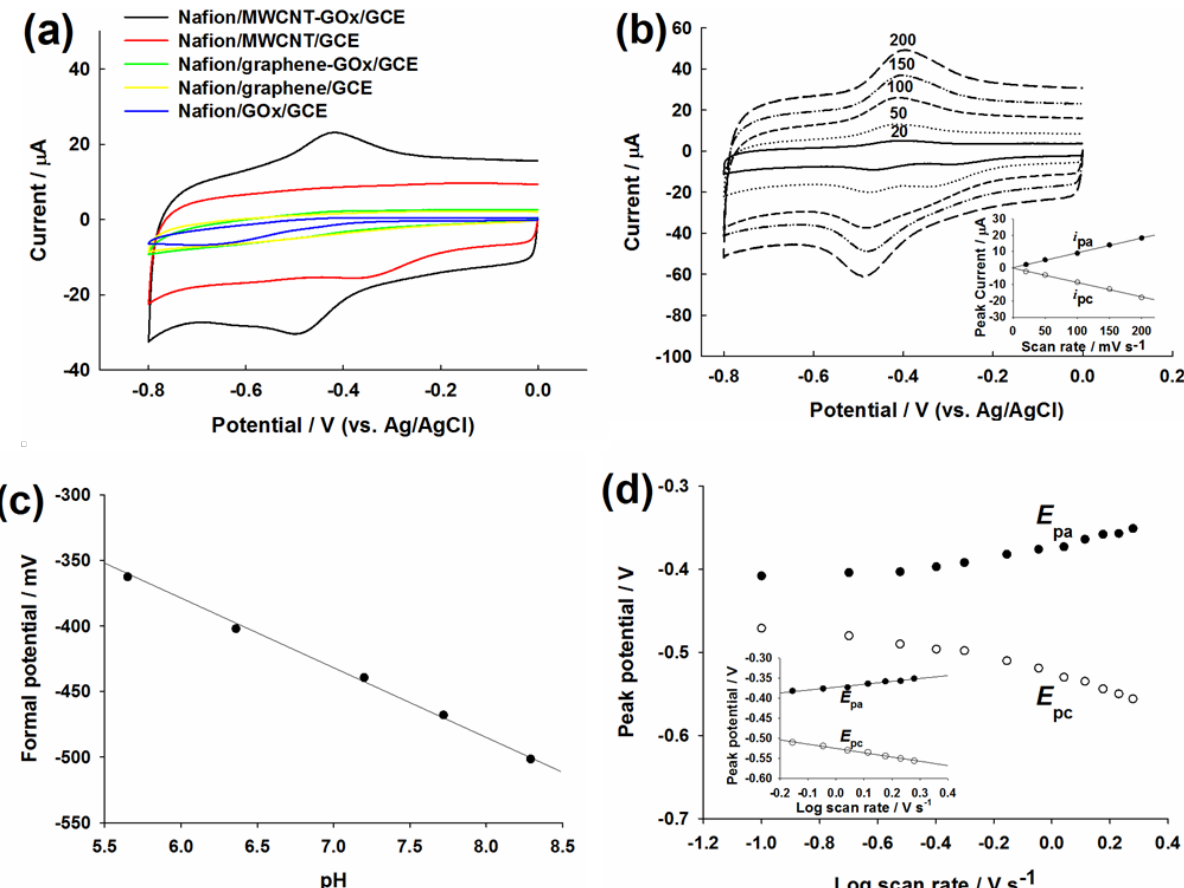
Figure 2a shows the CVs of Nafion/GOx/GCE (blue), Nafion/graphene/GCE (yellow), Nafion/MWCNT/GCE (red), Nafion/graphene-GOx/GCE (green) and Nafion/MWCNT-GOx/GCE (black) in nitrogen (N )-saturated 50 mM PBS at 100 mV s − 1 . Rectangle-shaped CVs were observed on 2 the Nafion/graphene/GCE (yellow) and the Nafion/MWCNT/GCE (red) in the applied potential range. The double-layer capacitance of Nafion/MWCNT/GCE was significantly greater than Nafion/graphene/GCE. Figure 2. ( a ) CVs of Nafion/GOx/glassy carbon electrodes (GCE) (blue), Nafion/graphene/GCE (yellow), Nafion/MWCNT/GCE (red), Nafion/graphene-GOx/GCE (green) and Nafion/MWCNT-GOx/GCE (black) in N -saturated PBS at 100 mV s − 1 ; ( b ) 2 The effect of scan rate (20, 50, 100, 150 and 200 mV s − 1 ) on the DET of GOx on Nafion/MWCNT-GOx/GCE in N -saturated PBS. Inlet: the linear relation between i (or 2 pc i ) and v ; ( c ) The relation between the formal potential (observed on Nafion/MWCNT-GOx/ pa GCE) and different pH values: 5.65, 6.36, 7.2, 7.72, 8.29. Scan rate = 100 mV s − 1 ; ( d ) Plot of E (of the Nafion/MWCNT-GO x /GCE) vs. log v , v = 0.1, 0.2, 0.3, 0.4, 0.5, 0.7, 0.9, p